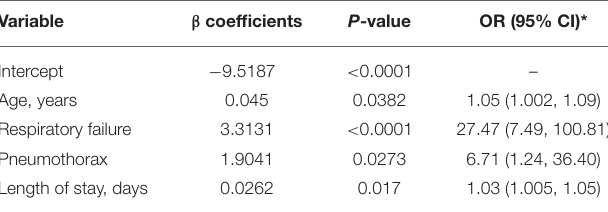
TABLE 2 | Firth’s penalized logistic regression for in-hospital mortality between 2015 and 2017.